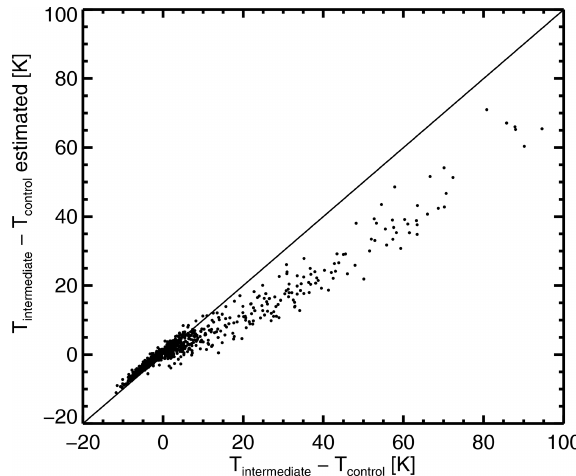
Figure 4. Scatter plot of change in channel 92v brightness temper- ature, relative to control, when going to the “intermediate” physical configuration from Sect. 5.4 (Land C av , CV Liu 3-bullet, LS ARTS sector, CI H13). On the y axis this is estimated using the assump- tion of linearly additive perturbations, by subtracting T Control from Eq. (4). On the x axis the intermediate configuration has been eval- uated by running an experiment with exactly that